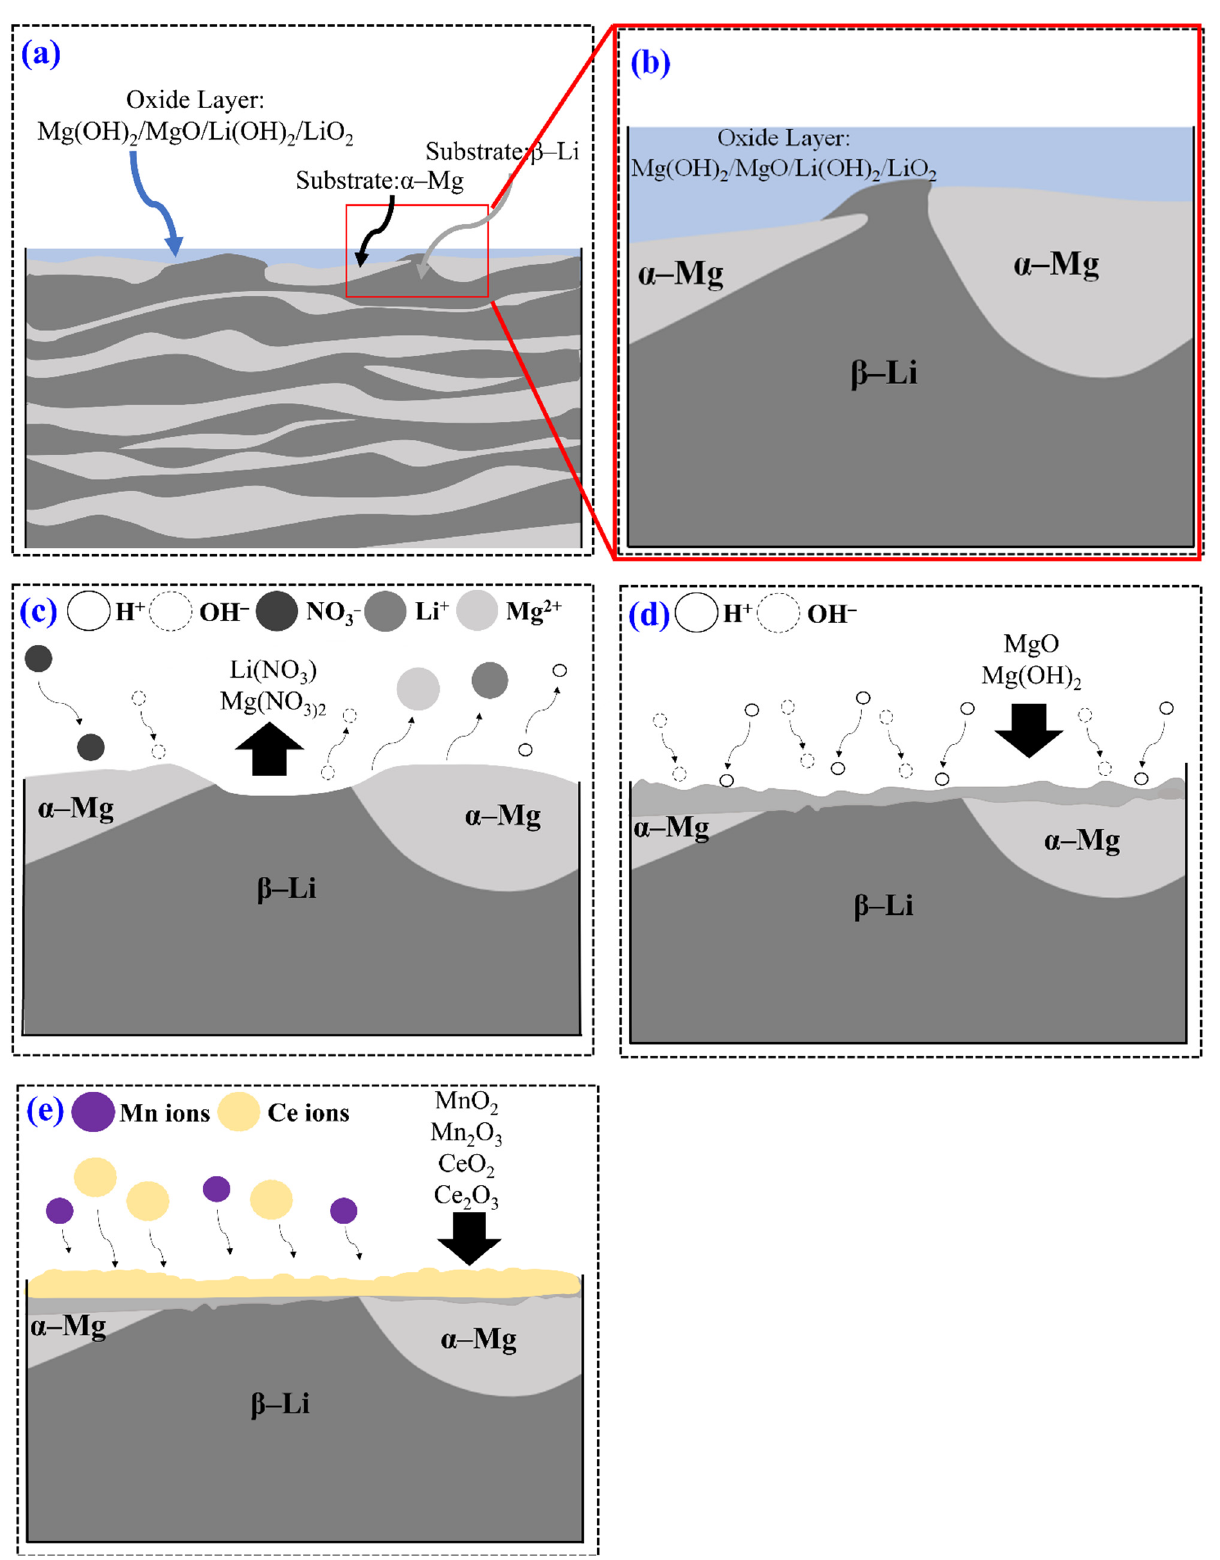
Figure 13. A schematic illustration of ( a ) initial LZ91 Mg alloy in natural surroundings, ( b ) partially enlarged image in ( a ), ( c ) acid pickling pretreatment, ( d ) initial immersion in conversion coating solution, and ( e ) the deposition of Mn-Ce conversion coating on LZ91 Mg alloy.